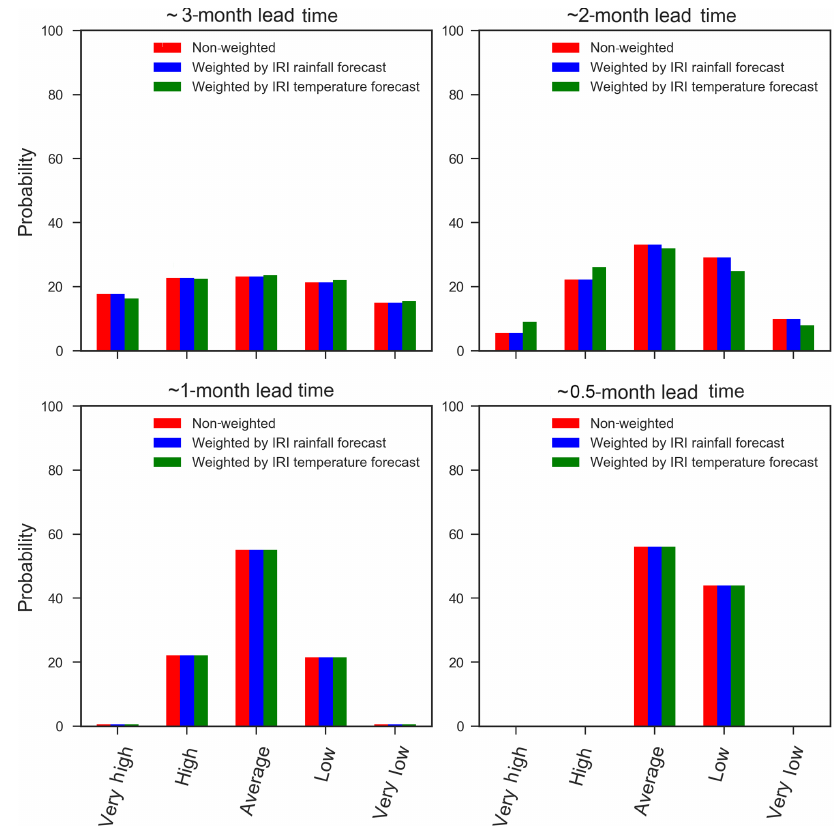
Figure 16. Probability of yield forecast for the 2011 growing season when weighted by IRI seasonal forecast of rainfall (blue), when weighted by IRI seasonal forecast of temperature (green) and when no weightings are used (red). The x axis represents the pentile categories used in the yield forecast.